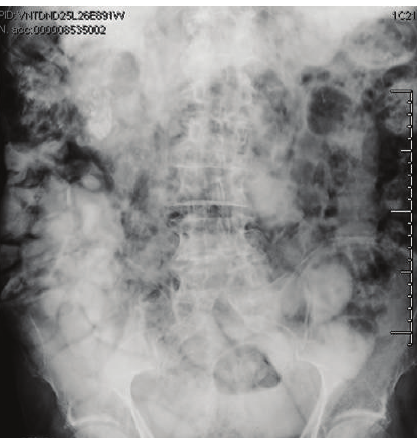
Figure 1: Plain abdominal film showing gas in the jejunal wall.